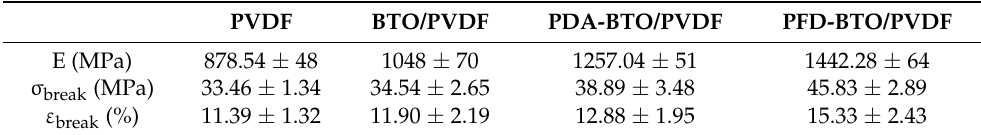
Table 2. Mechanical properties of as-printed films. E—Young’s modulus; σ break —ultimate tensile strength; ε break —strain-to-failure. PVDF BTO/PVDF PDA-BTO/PVDF PFD-BTO/PVDF E